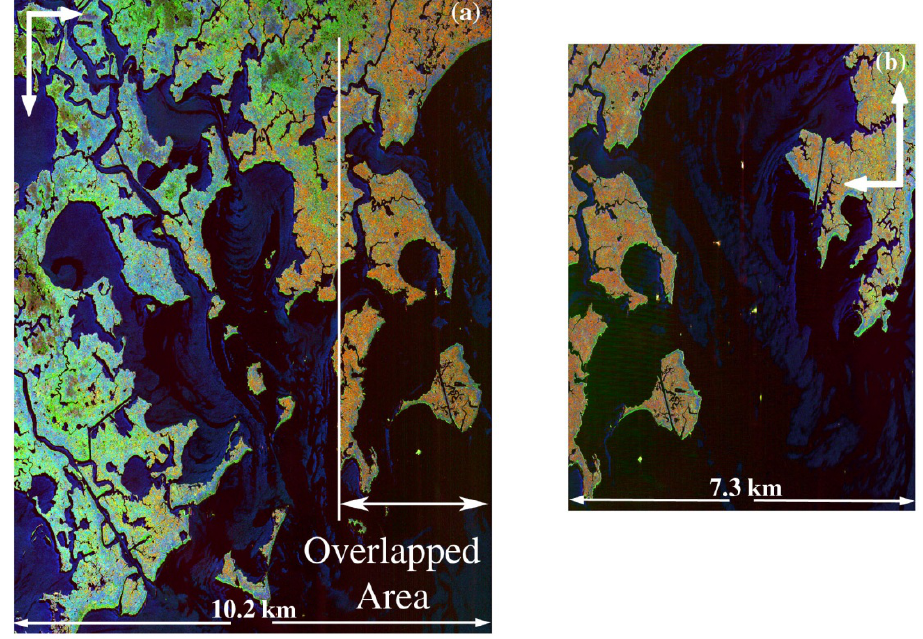
Figure 13. Results of the FD decomposition of the 2010 MLC data of the (a) Barataria Bay (BB) and (b) Grand Isle (GI) flight lines, with the overlap area common to the BB, GI, and MRD lines indicated. MRD, BB, and GI renditions used the same color reference